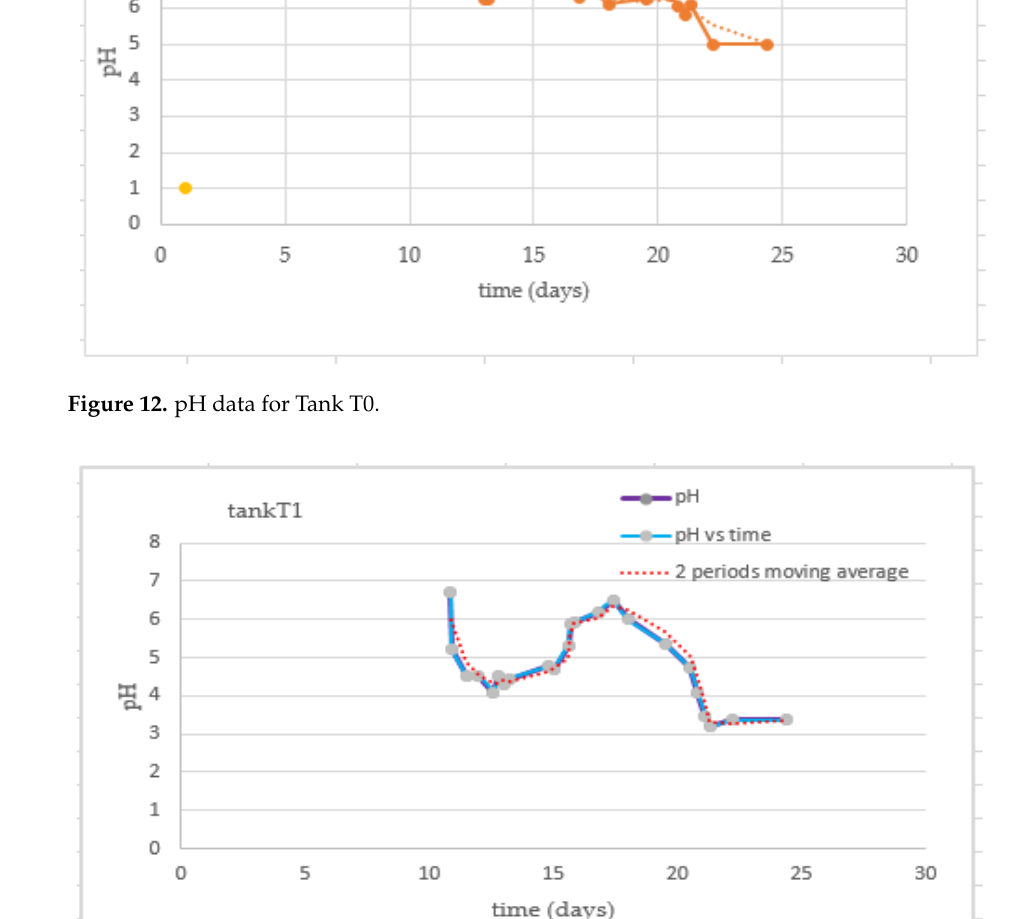
Figure 13. pH data for Tank T1.